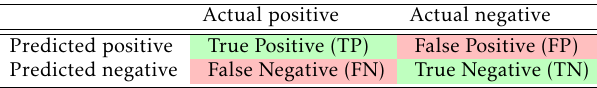
Table 4. Confusion matrix summarizing the outcome of any binary